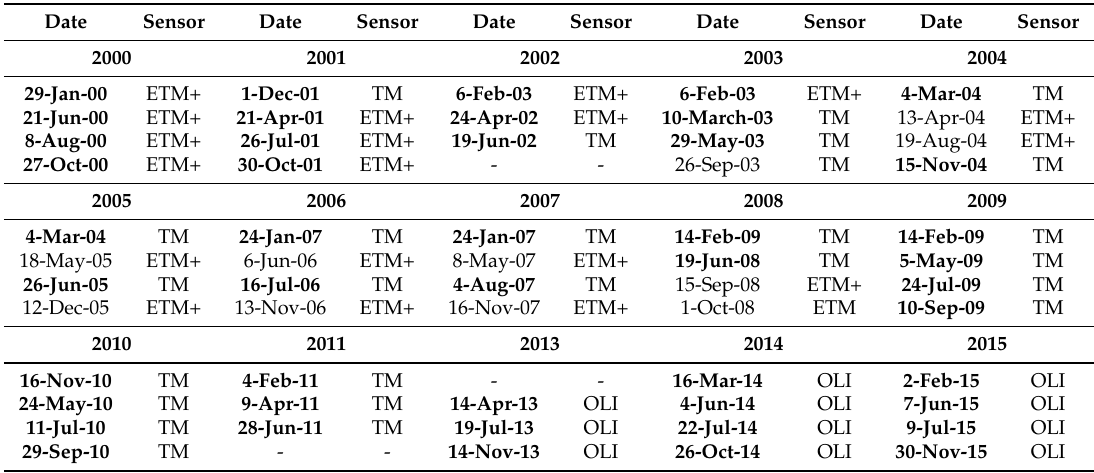
Table 1. Landsat images analyzed in this study. In bold are those used for the